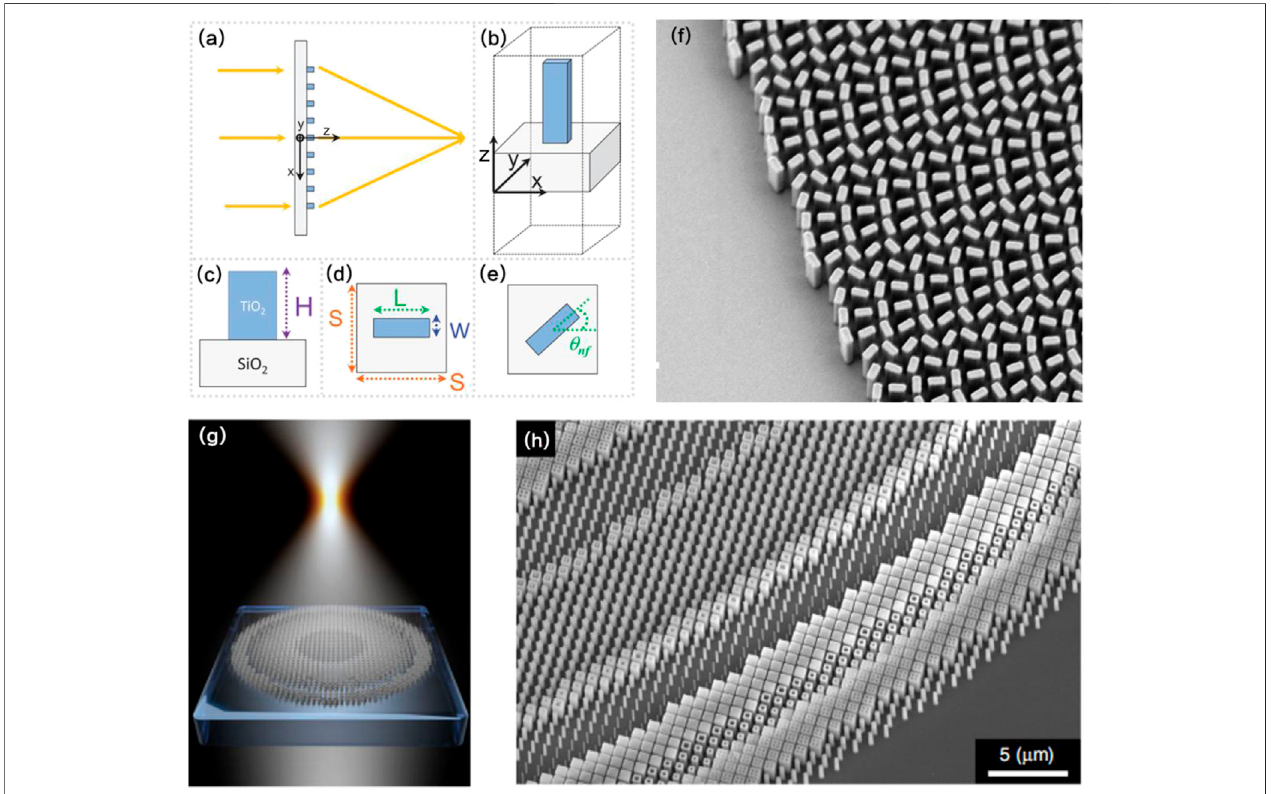
FIGURE4|(A) Schematicofthemetalensanditsbuildingblock,theTiO 2 nano fi n. (B) ThemetalensconsistsofTiO 2 nano fi nsonaglasssubstrate. (C , D) Sideand top viewsof the unit cell showing height H, width W, and length L of the nano fi n, with unit cell dimensions S × S. (E) The required phase is imparted bythe rotationof the nano fi n by an angle θ nf , according to the geometric Pancharatnam-Berry phase. (F) SEM micrograph of the fabricated meta lens. Source : reproduced from Ref. 60. (G) Schematic of a broadband achromatic meta lens composed of meta-units with complex cross sections, showing dispersionless focusing. (H) SEM images of fabricated meta-lenses using meta-units. Source : reproduced from Ref.